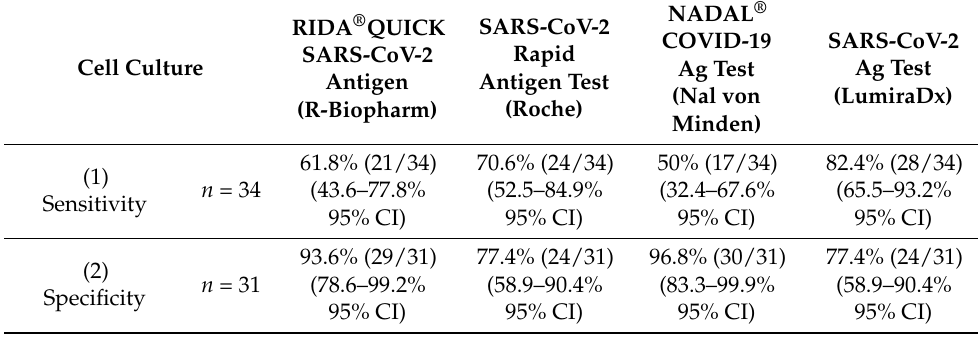
Figure 2. Cell culture results in correlation with the log 10 RNA copies/mL of the ORF1 gene rRT-PCR reactive samples including mean and standard deviation bars ( n = 64, 10 cytotoxic samples excluded). Table 3. Sensitivity and specificity of the examined SARS-CoV-2 Ag-RDTs. (1) Sensitivity % (cell culture-positive samples), (2) specificity % (cell culture-negative samples).